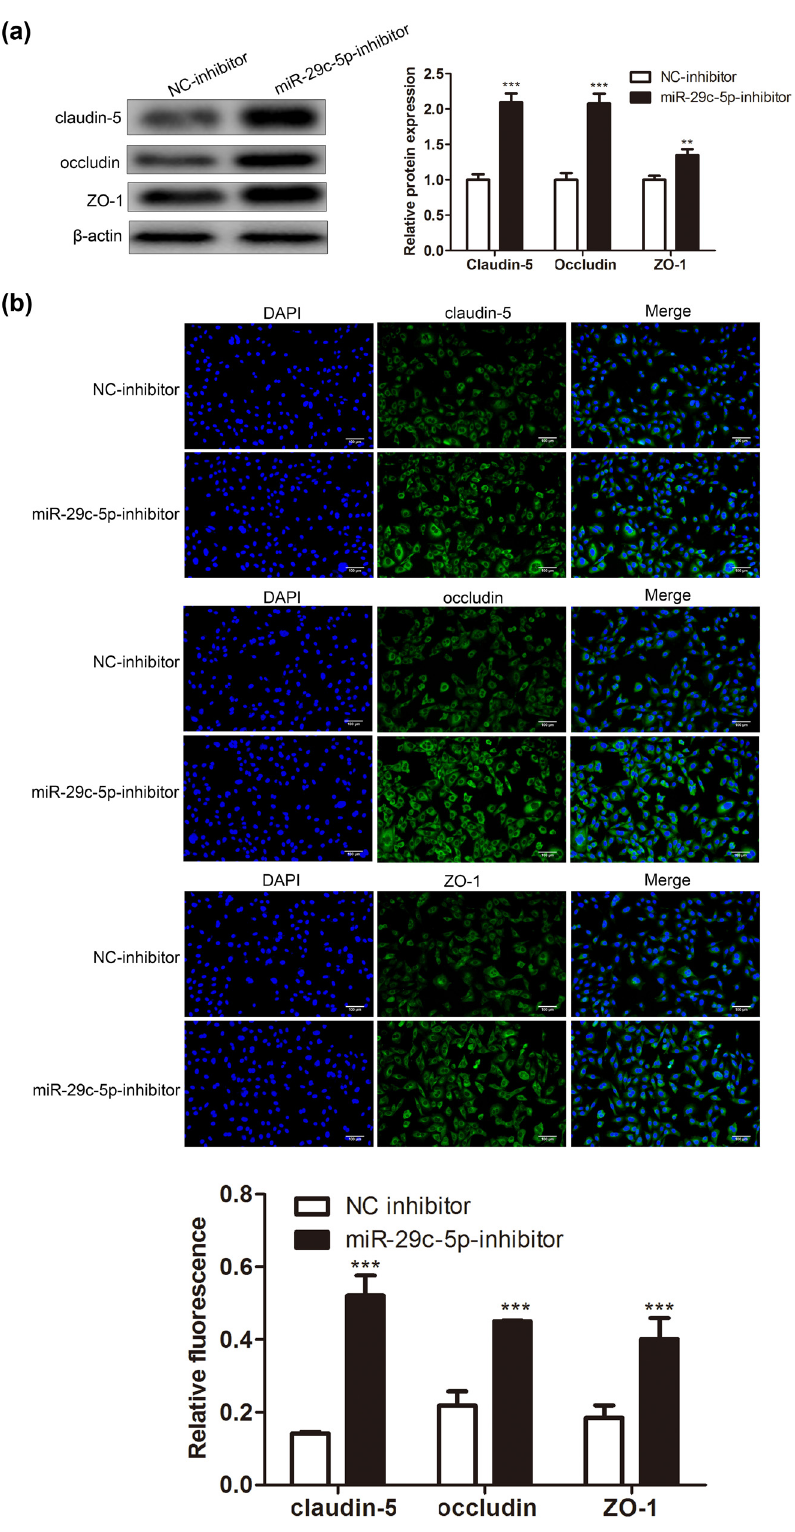
Figure 3: In fl uence of miR - 29c - 5p on the TJP destruction of BMECs caused by OGD - treated astrocytes. Astrocytes transfected with miR - 29c - 5p inhibitor or NC - inhibitor were treated with OGD for 3 h, and the cells were cocultured with BMECs for 24 h. ( a ) The protein levels of TJPs claudin - 5, occludin, and ZO - 1 were determined using Western blot. ( b ) Immuno fl uorescence staining assay was applied to quantify the claudin - 5, occludin, and ZO - 1 expressions ( scale bar: 100 µm ) . Data are presented as an average of three independent assays. ** P < 0.01, *** P < 0.001 vs NC -